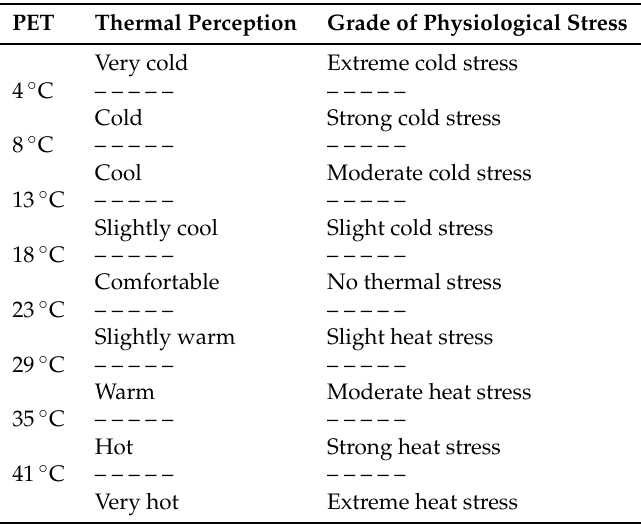
Table 1. Thermal perception and stress classification for human-beings for Physiologically Equivalent Temperature (PET) (with an internal heat production of 80W and a heat transfer resistance of clothing of 0.9clo) after Matzarakis and Mayer